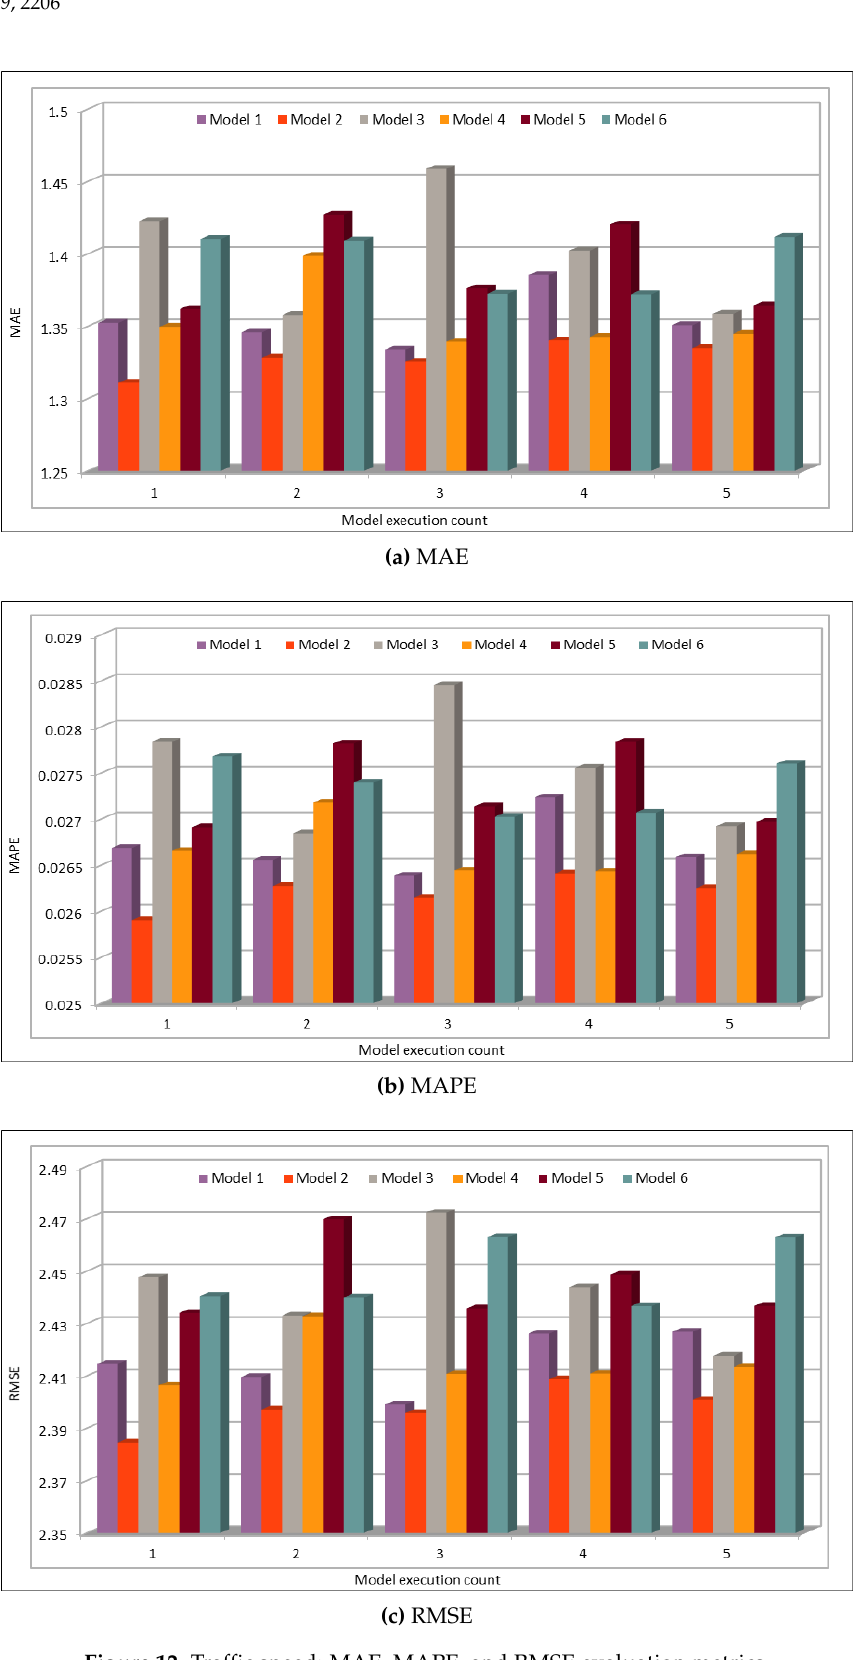
Figure 12. Traffic speed: MAE, MAPE, and RMSE evaluation